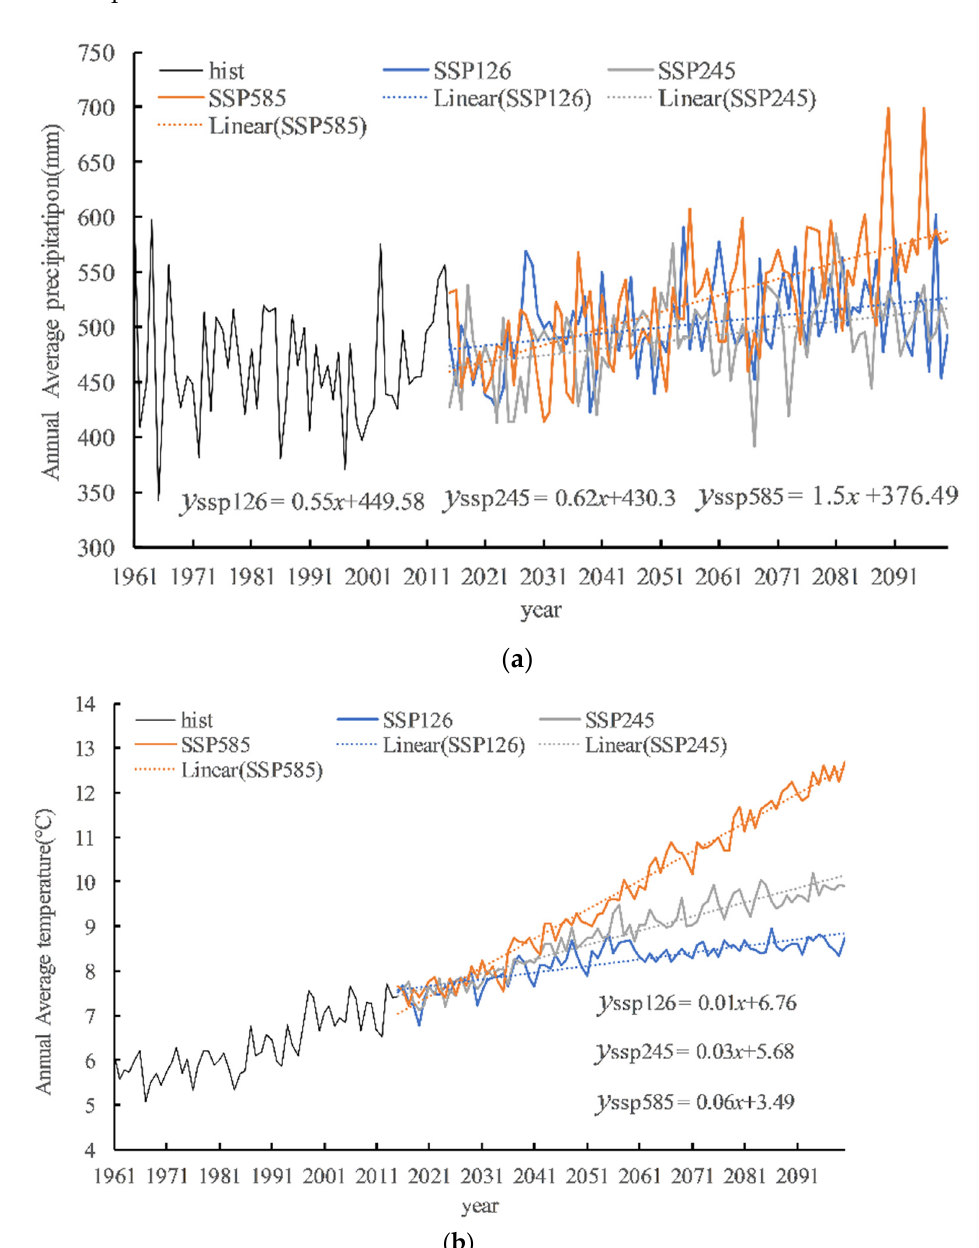
Figure 6 . Annual average precipitation and temperature under SSP126, SSP245, and SSP585 from 1961 to 2099 over the Yellow River Basin; ( a ) the annual average precipitation and ( b ) the annual average temperature.